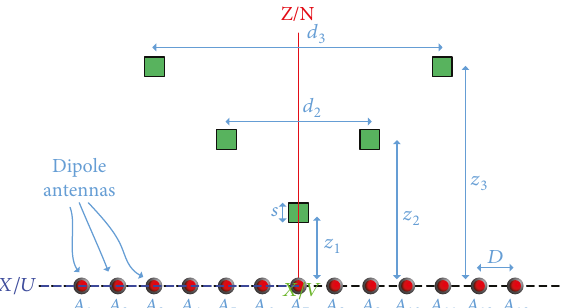
Figure 3: Cross-section view for the imaging setup in FEKO software.